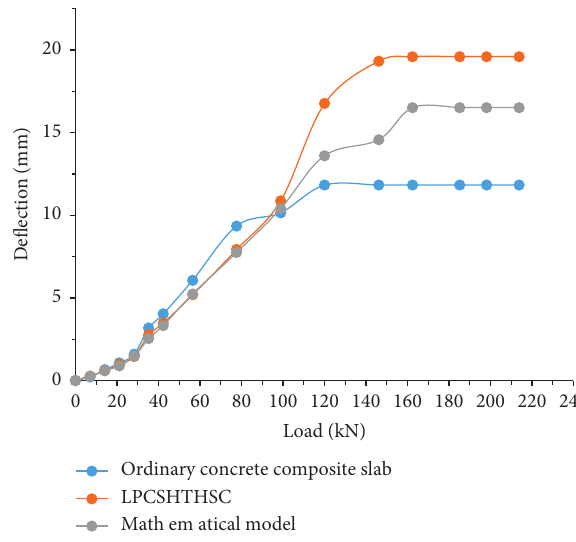
Figure 39: Comparison of deflection/load relation curves between traditional composite slab and